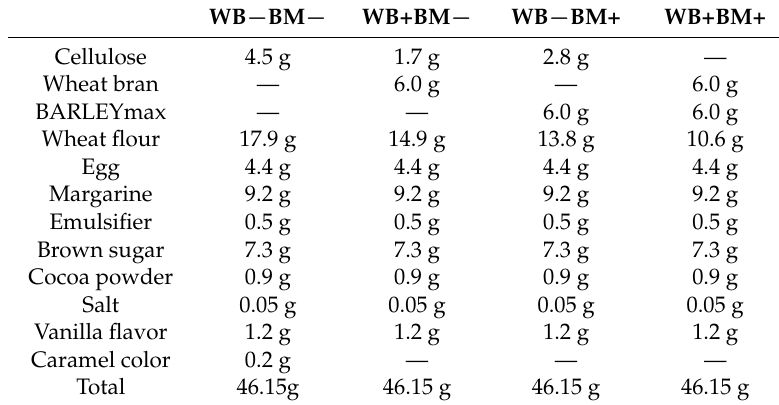
Table 2. Components of test foods.